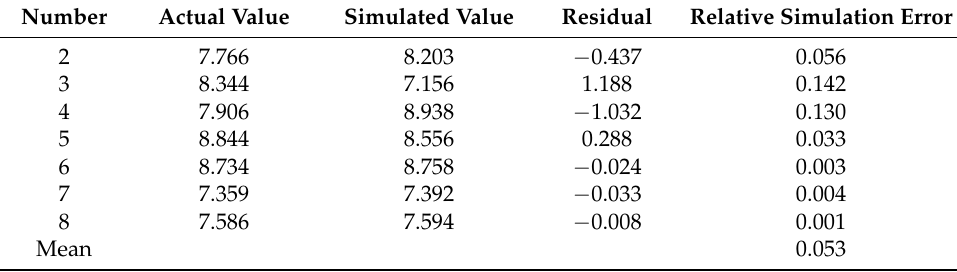
Table 11. Simulation error check of GM (0, 5) model for flexural